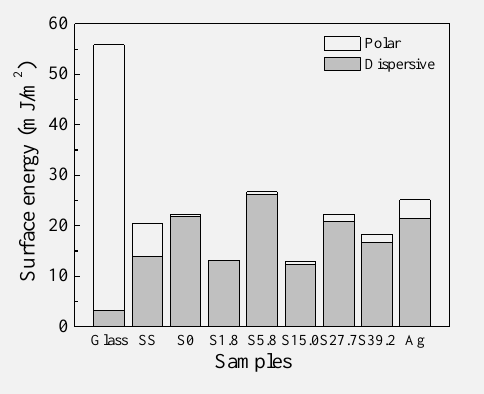
Figure 3. Surface energy of the glass, stainless steel, Cr – Ag and Ag film samples.